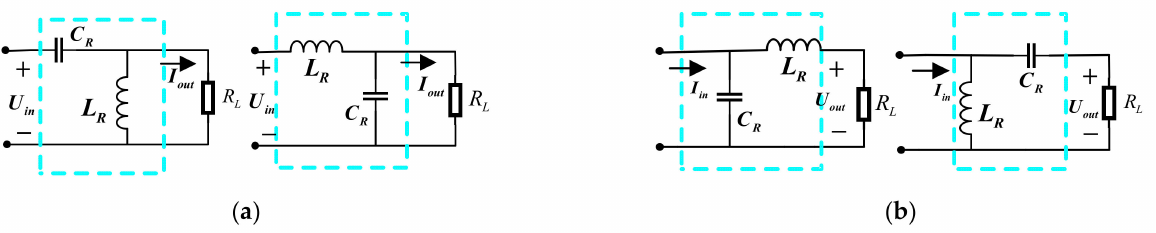
Figure 21. ( a ) Voltage to current at load side (I_L); ( b ) Current to voltage at load side